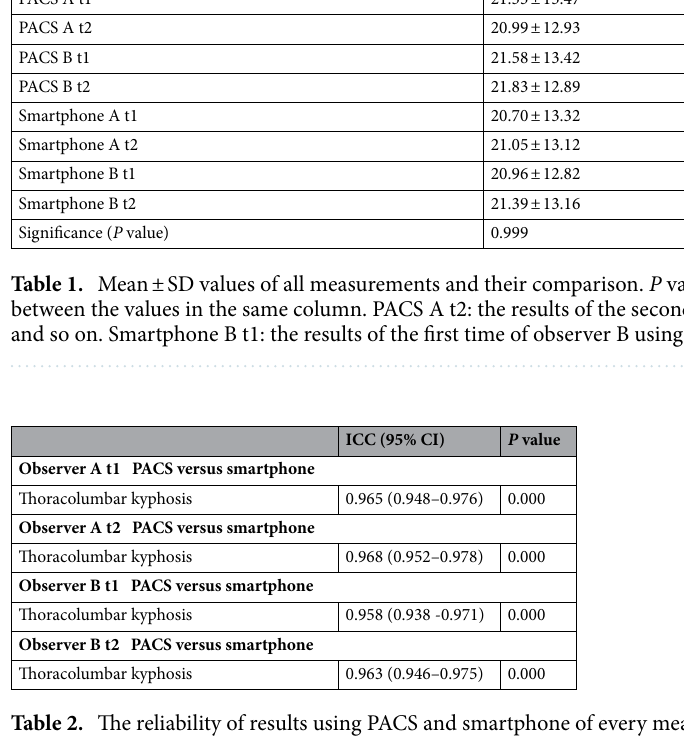
Table 2. The reliability of results using PACS and smartphone of every